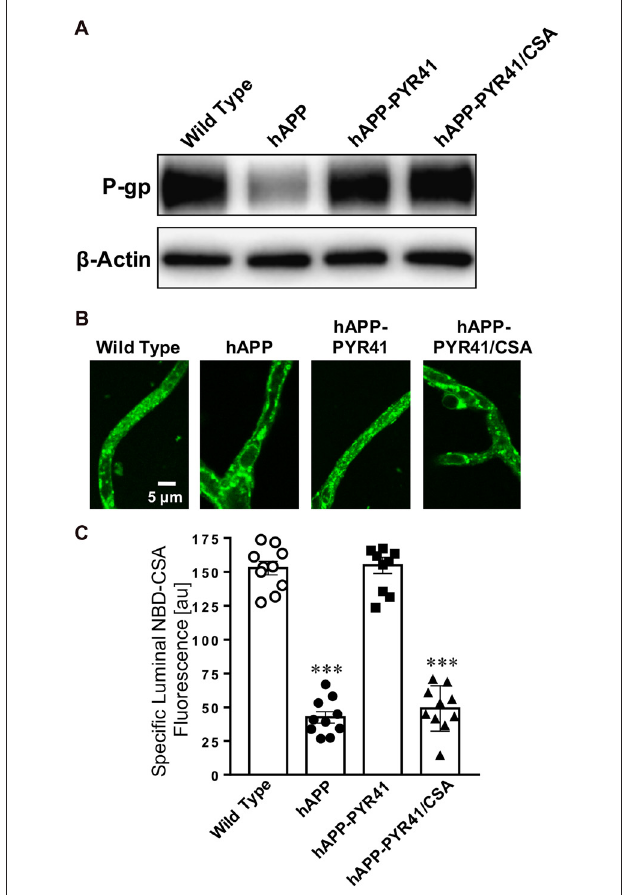
FIGURE 2 | PYR41 prevents reduction of P-gp protein expression and transport activity in human amyloid precursor protein (hAPP) mice. (A) Western blot showing that PYR41 treatment restored P-gp protein expression levels in hAPP mice compared to vehicle-treated wild type (WT) mice; β -actin was used as protein loading control. (B) Representative confocal images of brain capillaries isolated from WT, hAPP, hAPP-PYR41 and hAPP-PYR41/CSA mice after a 1 h incubation (steady state) with the fluorescent, P-gp-specific substrate NBD-CSA (2 µ M). (C) Data from ImageJ analysis of confocal images in (B) show that luminal NBD-CSA fluorescence was significantly reduced in brain capillaries from hAPP and hAPP-PYR41/CSA mice relative to brain capillaries from WT and hAPP-PYR41 mice. Specific NBD-CSA fluorescence is the difference between total luminal fluorescence and fluorescence in the presence of the P-gp-specific inhibitor PSC833, representing transport activity that is specific to P-gp. Data are mean ± SEM ( n = 10 capillaries per treatment group); arbitrary fluorescence units (scale 0–255). Statistics: ∗∗∗ p < 0.001 analysis of variance (ANOVA), significantly lower than WT control